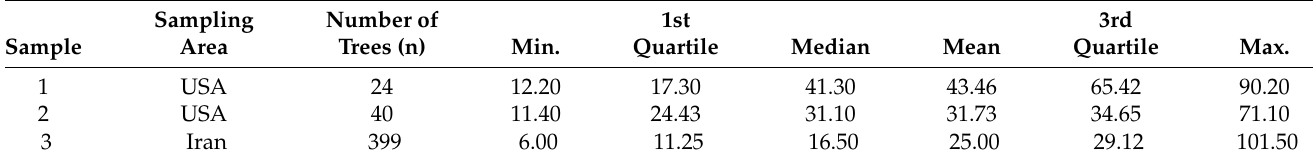
Table 6. Summary statistics for DBH